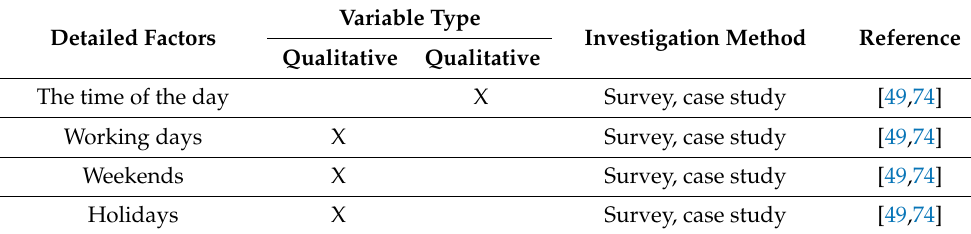
Table 15. Factors related to days of using the systems.